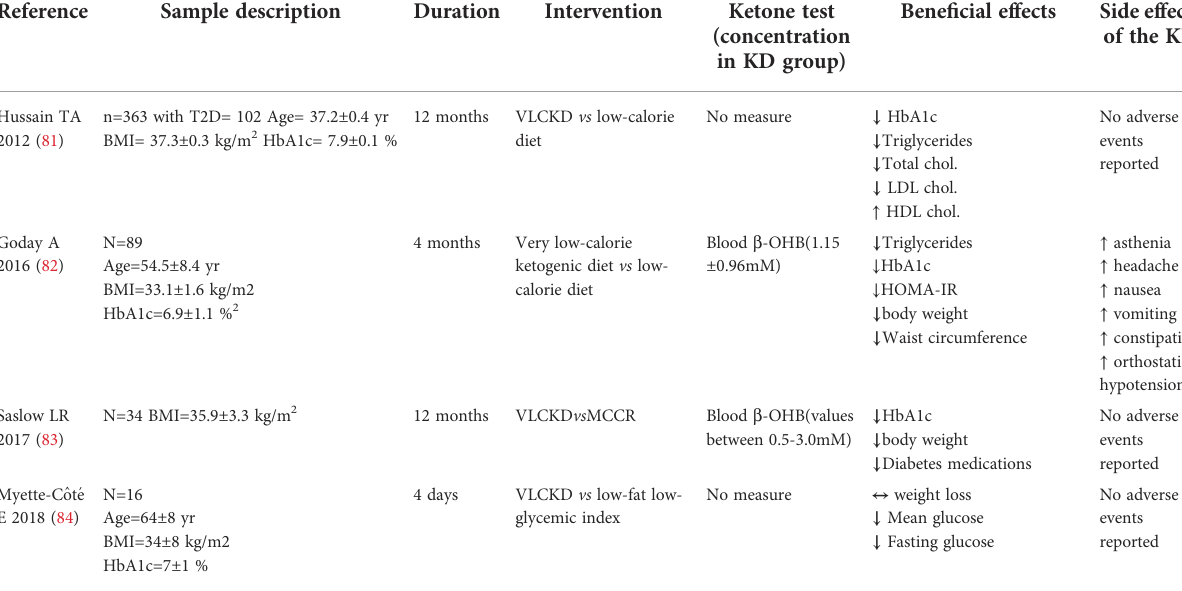
TABLE 3 Summary of trials evaluating KD effects vs comparative diet in subjects with type 2